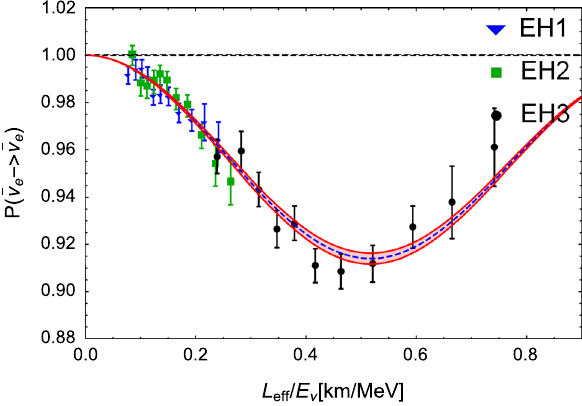
Fig. 2 The electron anti-neutrino survival probability versus effective propagationdistance L eff overanti-neutrinoenergy E ν .Thedashedblue curve indicates the prediction fitting directly to the measured Daya Bay values of P ee . The red band indicates a 1 σ confidence interval around the fitted prediction. The blue triangles, green rectangles and black dots are the binned data of the Daya Bay EH1, EH2 and EH3 from Ref. [20],